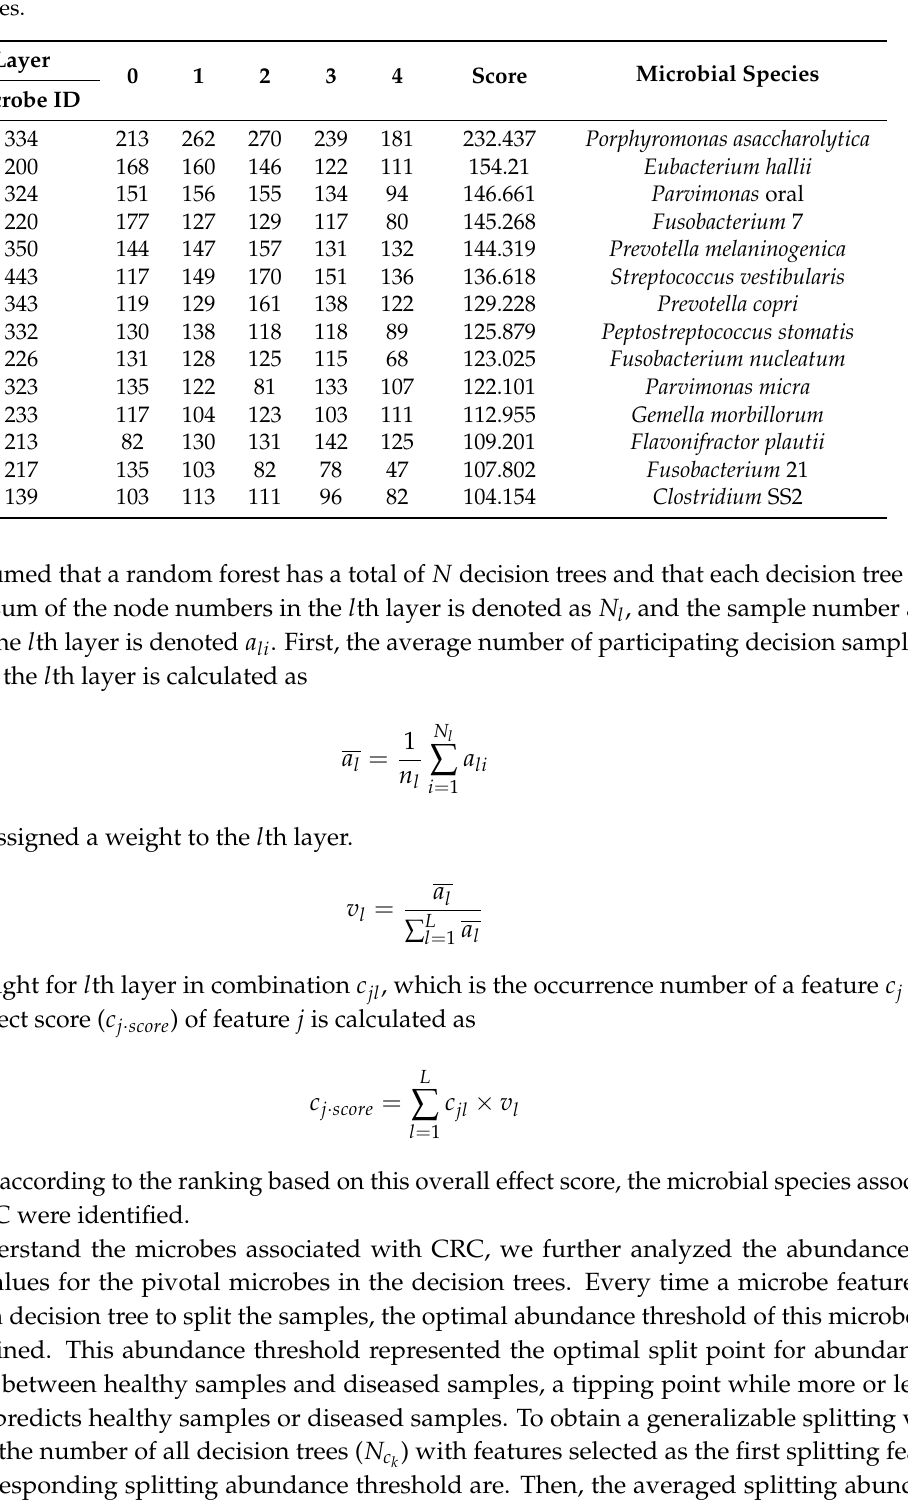
Table 2. Examples of the number of occurrences in various decision tree layers and the overall score of